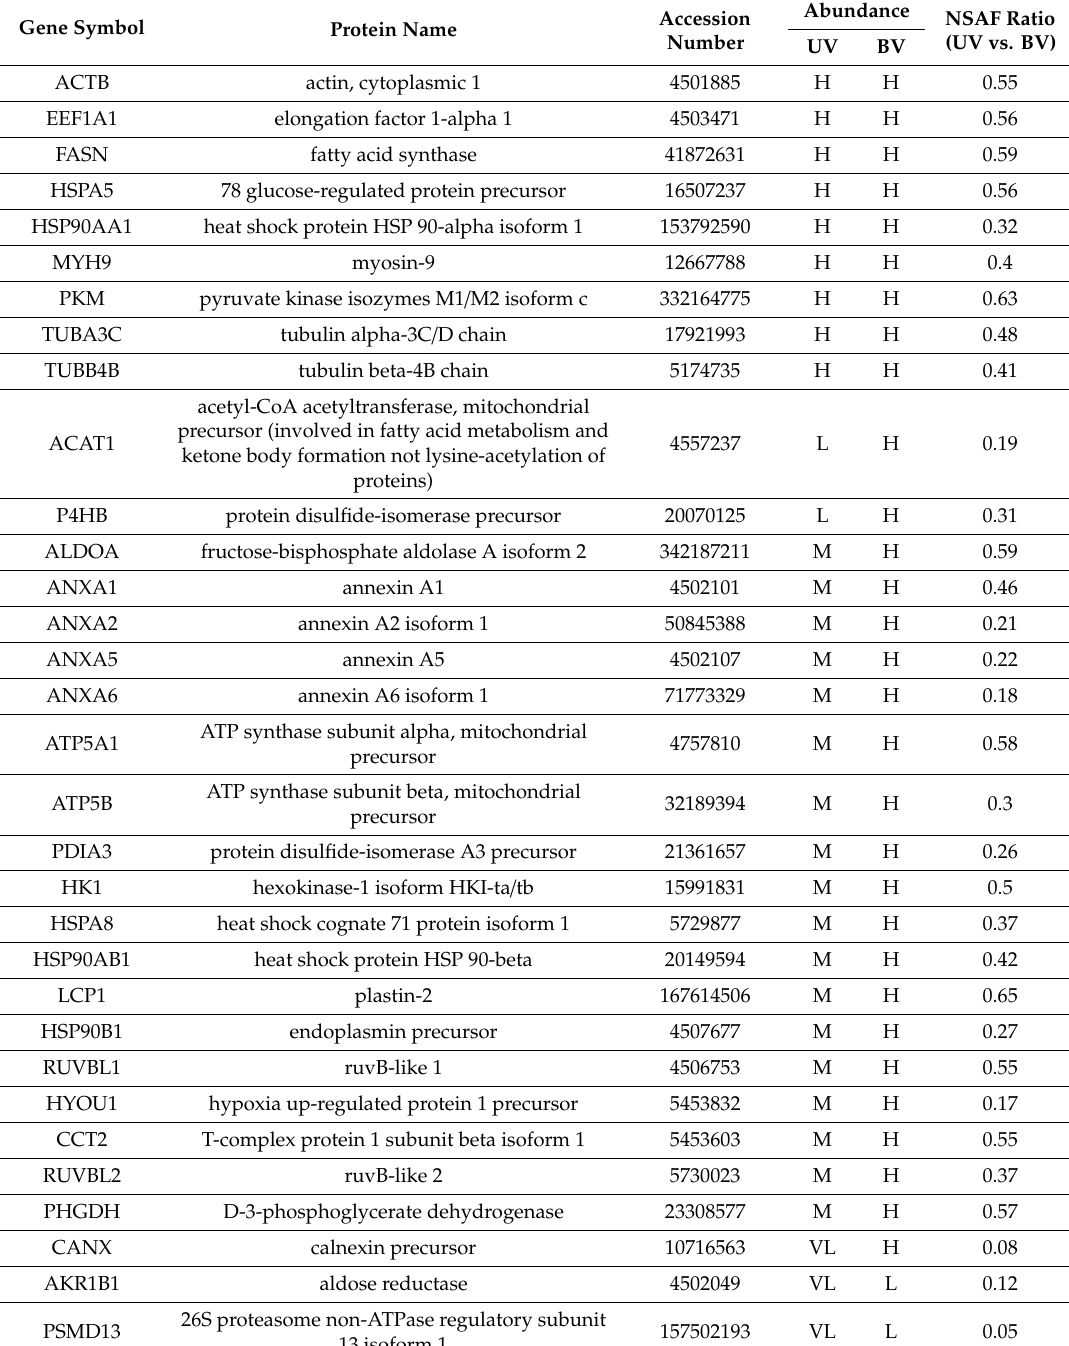
Table 1. Comparison of the enrichment of lysine-acetylated functional sperm proteins underexpressed in unilateral varicocele in comparison to bilateral